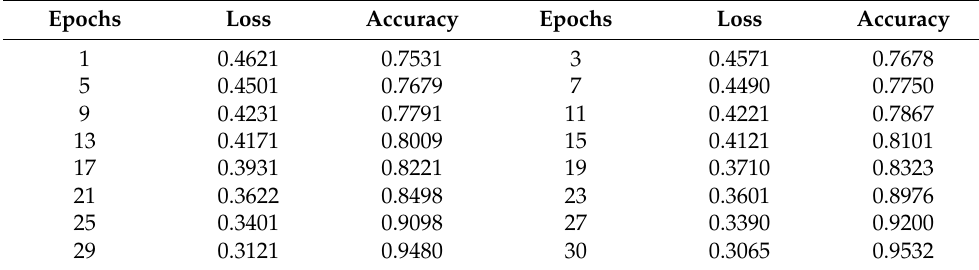
Table 8. The loss and accuracy of Alex net at the time of training.